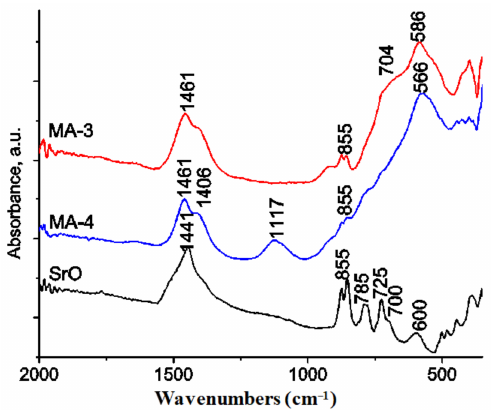
Figure 3. FT-IR spectra (fragment) of the initial SrCO 3 , MA-1 and MA-2 after mechanical activation for 10 min.